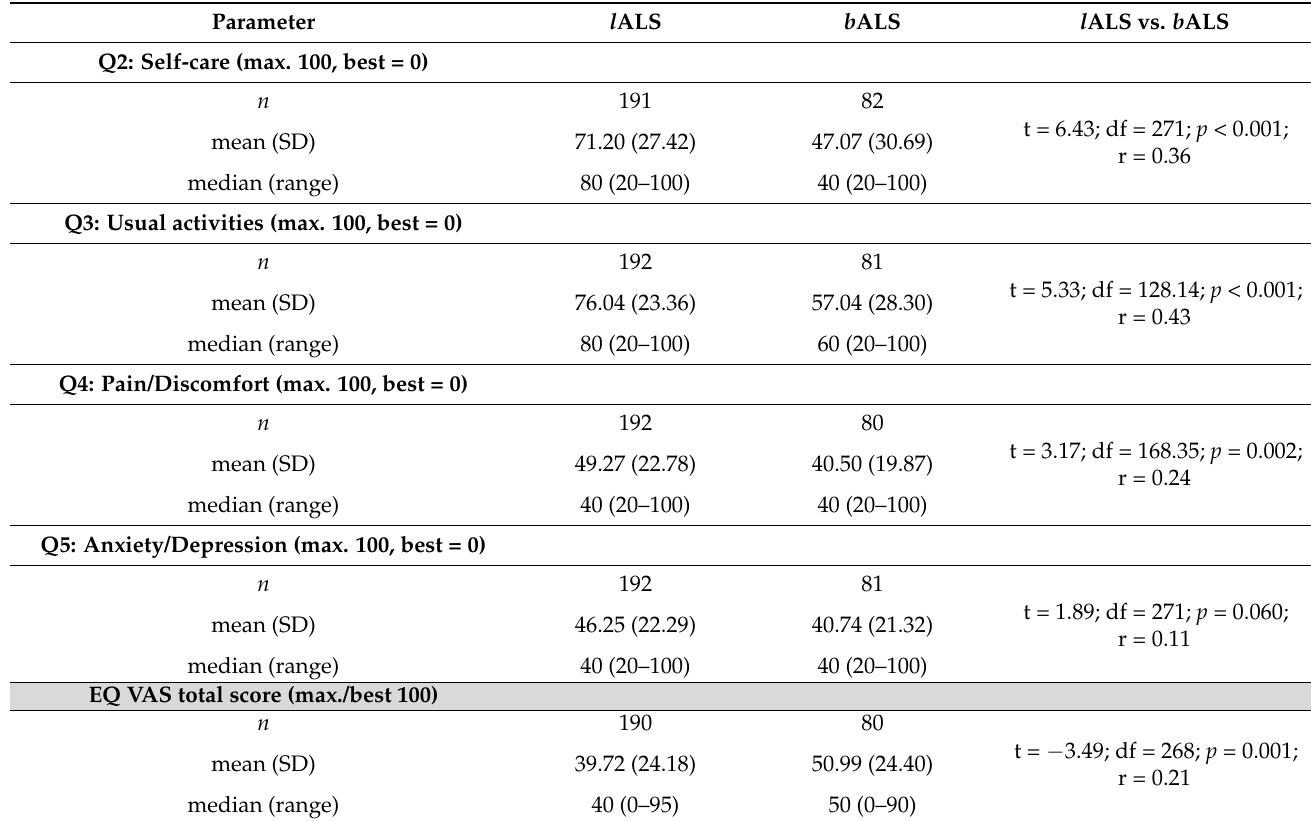
Table 4. Spearman’s rho correlation between the individual questions of the ALSAQ-5 and EQ-5D- 5L, and the ALSAQ-5 total score and the reversed EQ VAS score, with n representing the